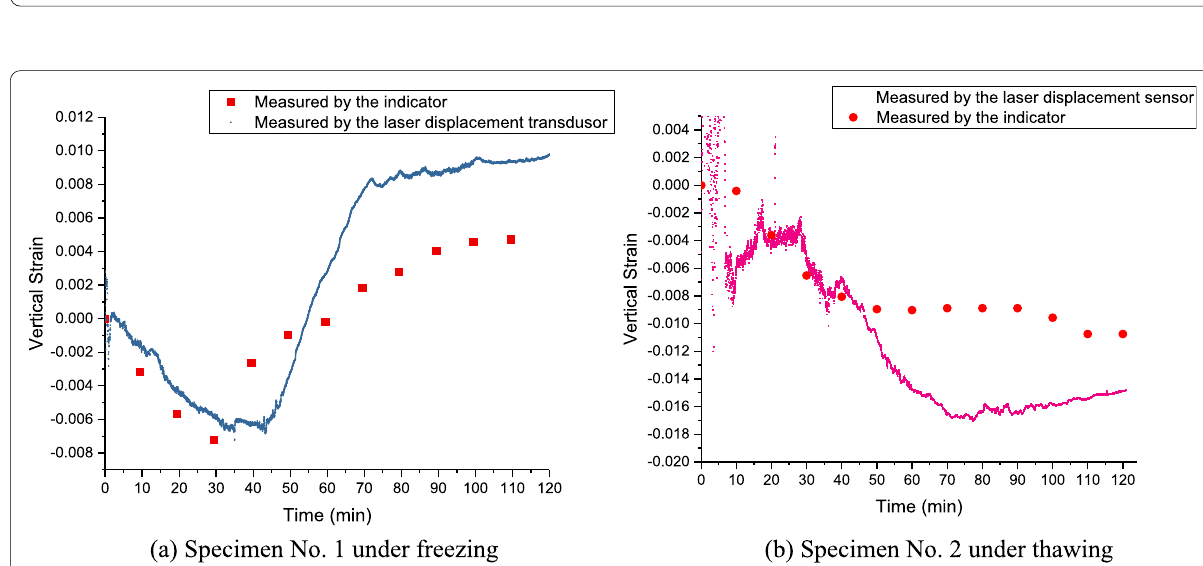
Fig. 2 Vertical volumetric strain of saturated silt specimen subjected to ( a ) freezing and ( b )